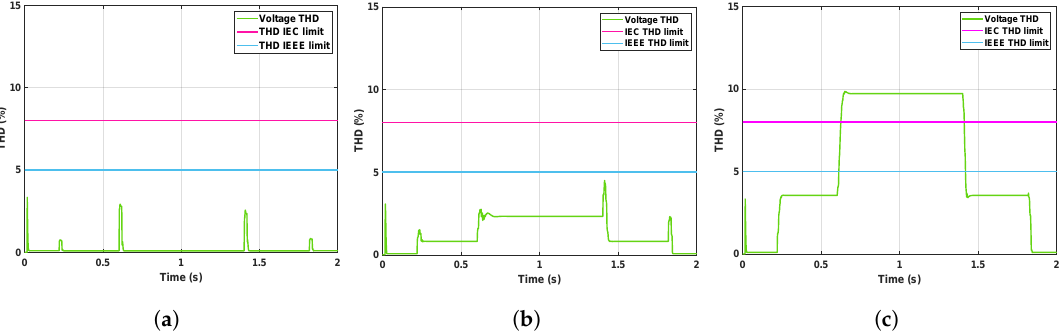
Figure 8. THD value of DER system output voltage. ( a ) 100% linear load with HC. ( b ) 100% non-linear load with HC. ( c ) 100% non-linear load without HC.